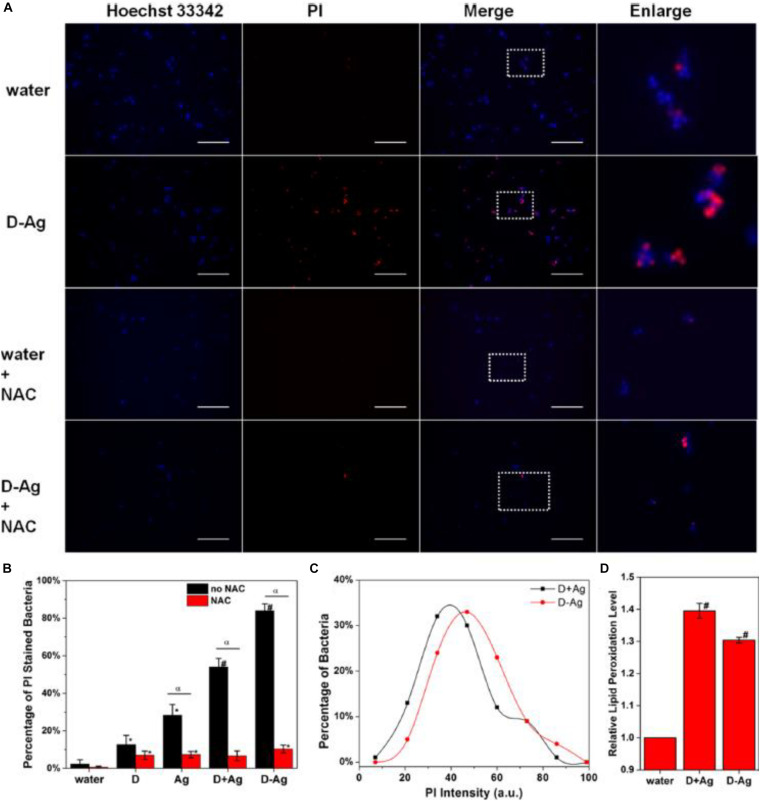
(A) Representative fluorescence images of the bacterial cells after 2 h treatment. (B) Percentage of PI-stained bacteria to show damaged bacterial membrane. * is significant against the water treated group, p < 0.05; # is significant against the water-treated group, p < 0.001. α is significant difference against non-NAC-treated group, p < 0.05. (C) Histogram of the PI intensity in each individual bacterial cell treated with D + AgNCs (black line) and D-AgNCs (red line). (D) Relative lipid peroxidation level after incubation for 2 h, where the lipid peroxidation of the water-treated group was set as 1. # is significant against the water treated group, p < 0.001. Reproduced with permission, copyright 2016, American Chemical Society.